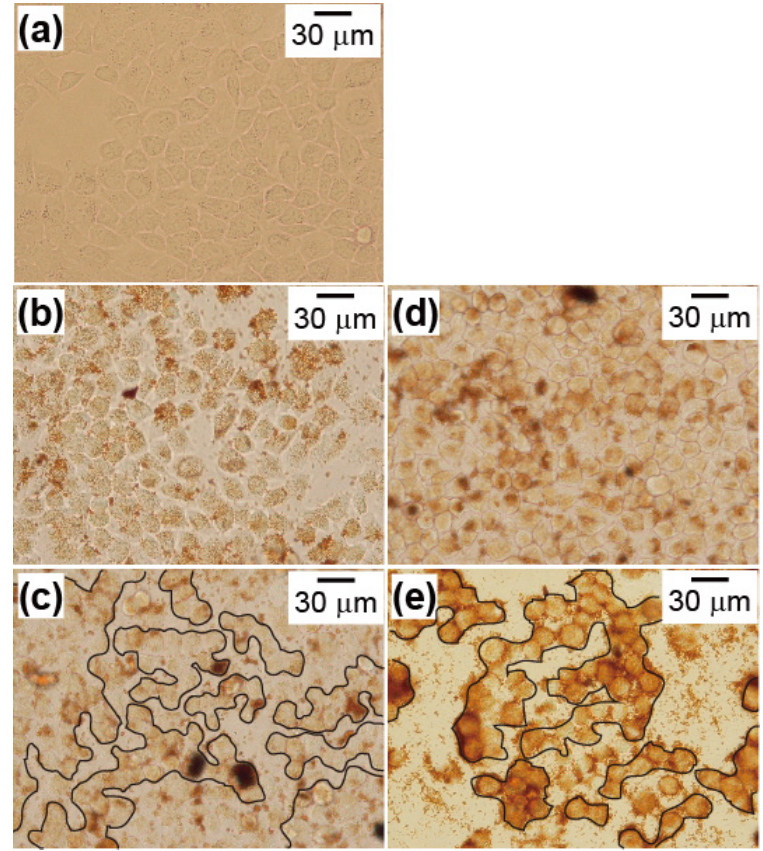
Figure 8. Images of HeLa cells in the presence of PEI-coated MNPs or MNP/antibody complexes and the application of an AC magnetic field for 1 h. Cell conditions and magnetic field intensities were: ( b ) PEI-coated MNPs and 210 Oe; ( c ) PEI-coated MNPs and 250 Oe; ( d ) complexes and 210 Oe; and ( e ) complexes and 250 Oe. The image in ( a ) is of the control cells in Figure 7. The AC magnetic field frequency was 210 kHz. The clusters in ( c ) and ( e ) are cell colonies. Cells had adhered and formed large colonies in ( a ), ( b ) and ( d ). However, cells were divided into a number of small colonies in ( c ) and ( e